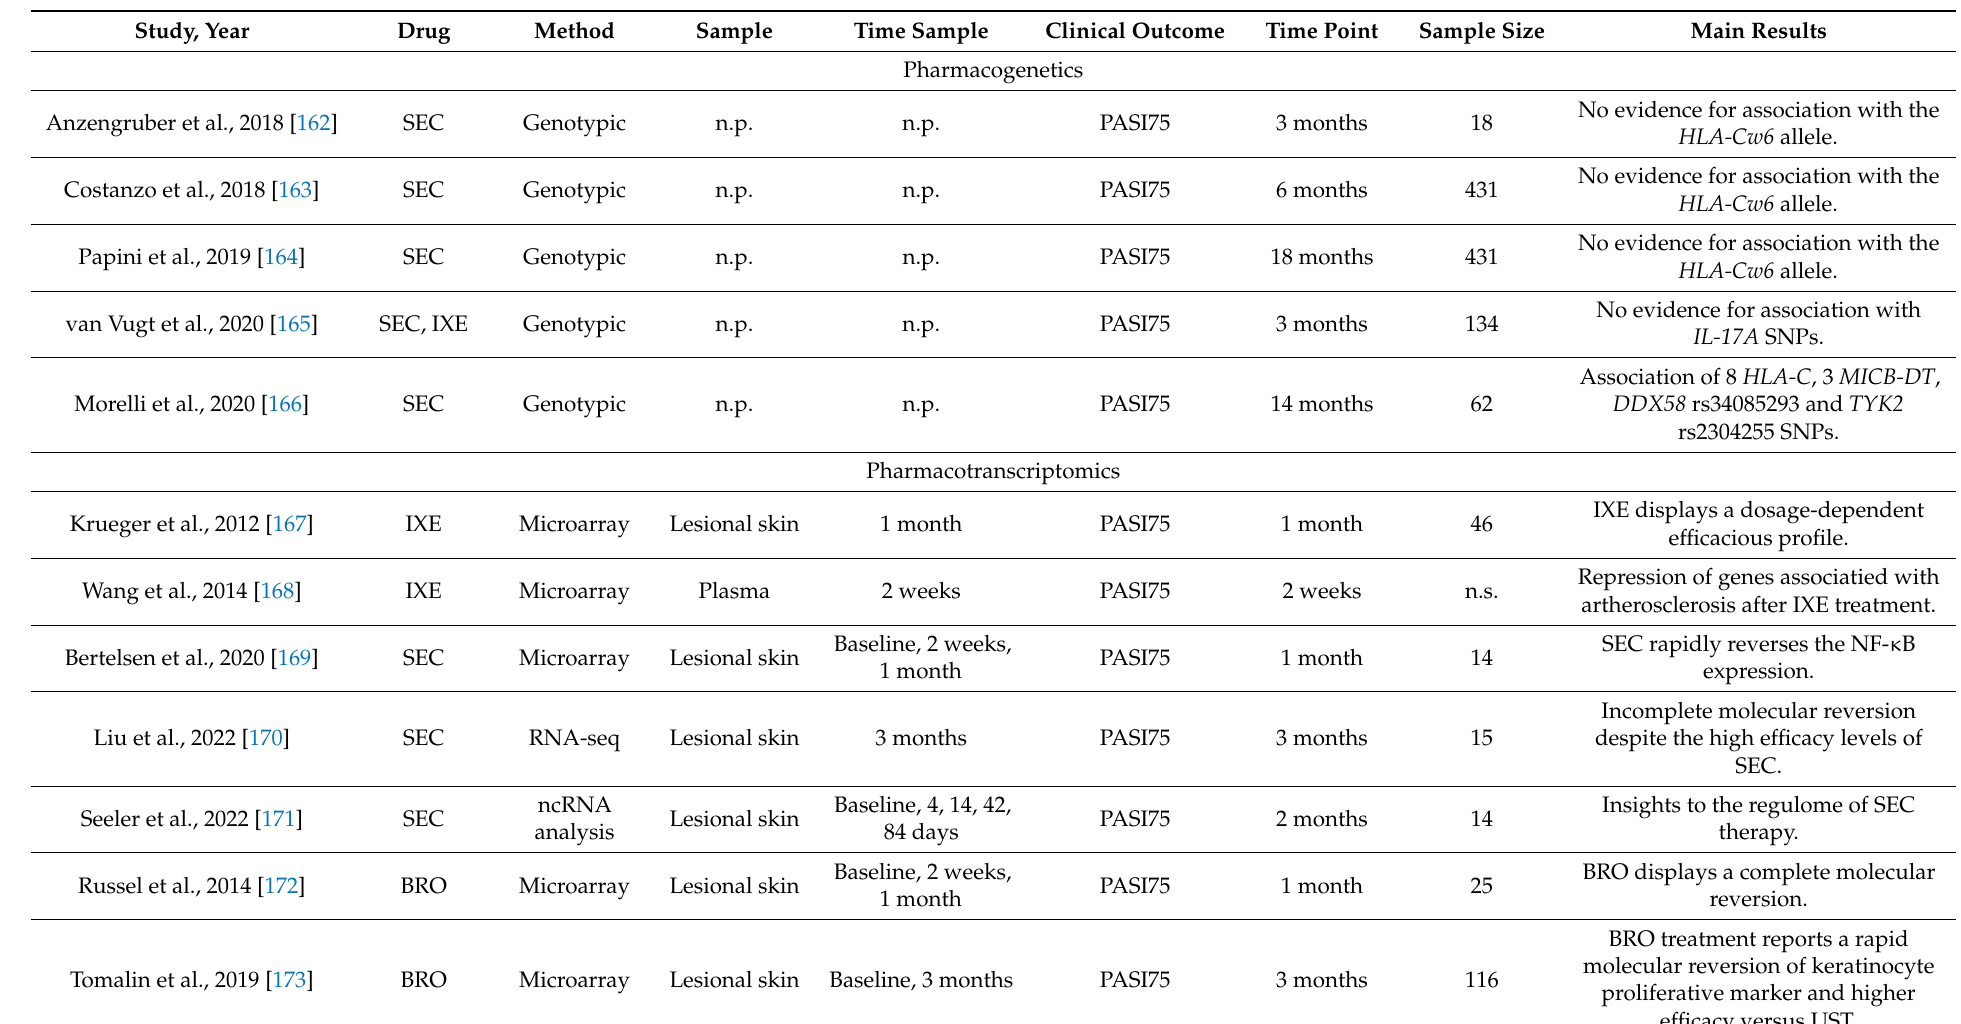
Table 5. Pharmaco-omic approaches applied in anti-IL17